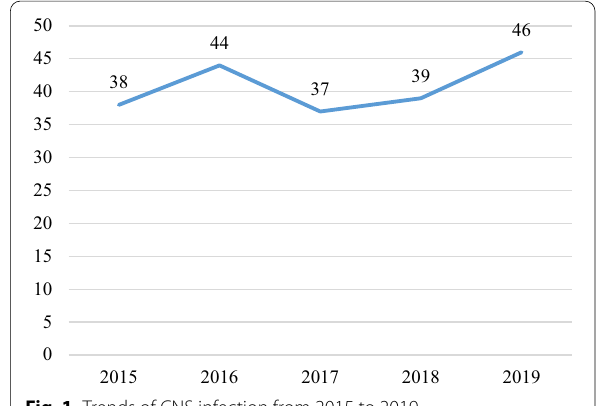
Fig. 1 Trends of CNS infection from 2015 to 2019